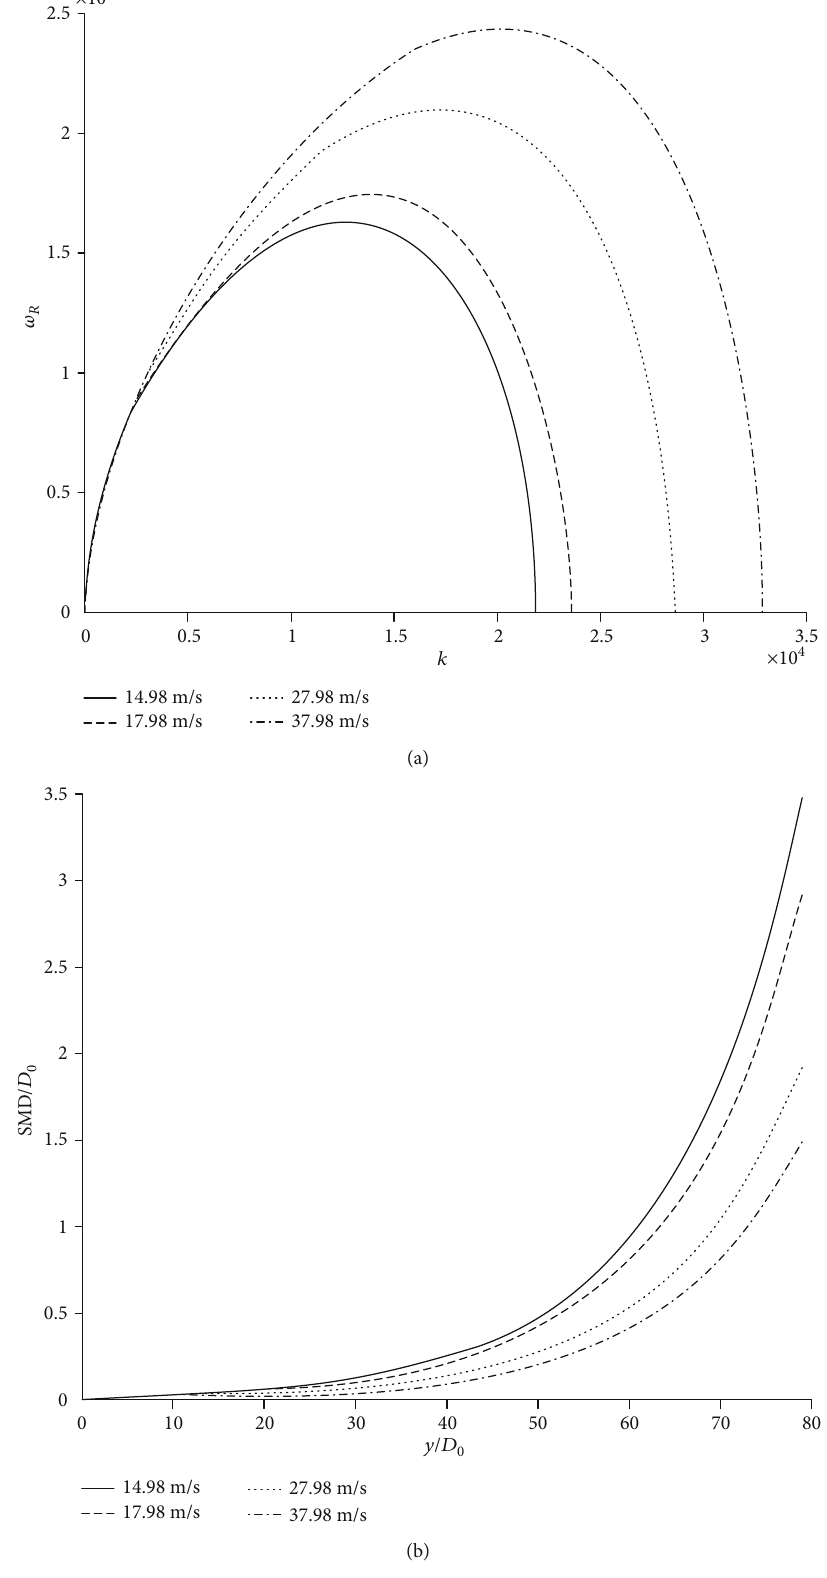
Figure 6: E ff ect of transverse gaseous velocity to (a) surface wave growth rate and (b) droplet size distribution ( σ = 0 : 0728 N/m 2 , ρ = 1 : 29kg/m 3 , and q = 96 : 35 1000kg/m 3 , ρ G